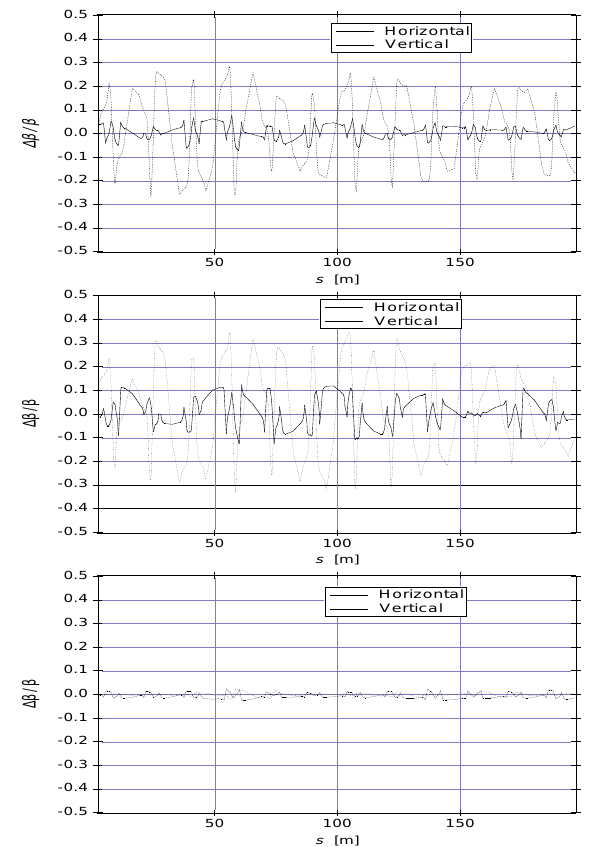
FIG. 5. Horizontal and vertical b beating with sextupoles turned off (top), with sextupoles turned on (middle), and with sextupoles turned on after optic is corrected